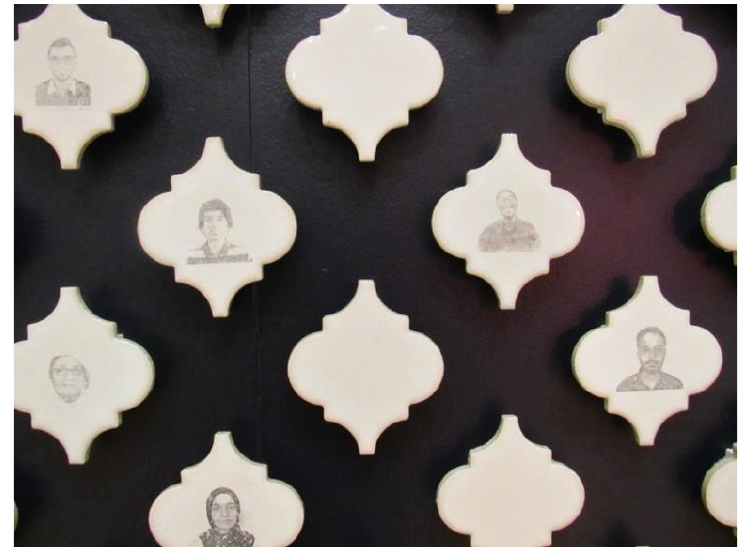
Figure 6 Sobia Ahmad, detail from Small Identities (2017 – ongoing). Photo transfers on